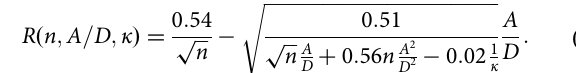
Fig. 2 Phase diagram and spin pro fi les of an isolated skyrmion and a rami fi ed stripe. a Energy (in arcsinh ð E Þ scale) as a function of κ ≡ π 2 D 2 / (16 AK ) (in log ð κ Þ scale) for various model parameters with very different exchange stiffness constant A , the Dzyaloshinskii – Moriya interaction coef fi cient D , and the effective perpendicular magnetic anisotropy constant K . E changes sign at κ = 1 that separate an isolated skyrmion from stripes and skyrmion crystals. b m z ( r ) is the z -component of magnetization at position r measured from the centre of an isolated skyrmion shown in the inset. Symbols are simulation data and the solid curve are theoretical fi t with skyrmion size R = 4.513 nm and skyrmion wall width w = 1.356 nm. c Spin pro fi le m z ( x ) of a stripe. Symbols are simulation data for stripes ① – ④ in the inset and the solid curve is the theoretical fi t with stripe width L = 8.95 nm and stripe wall width w = 1.82 nm. x is measured across the stripes and x = 0 is at the stripe